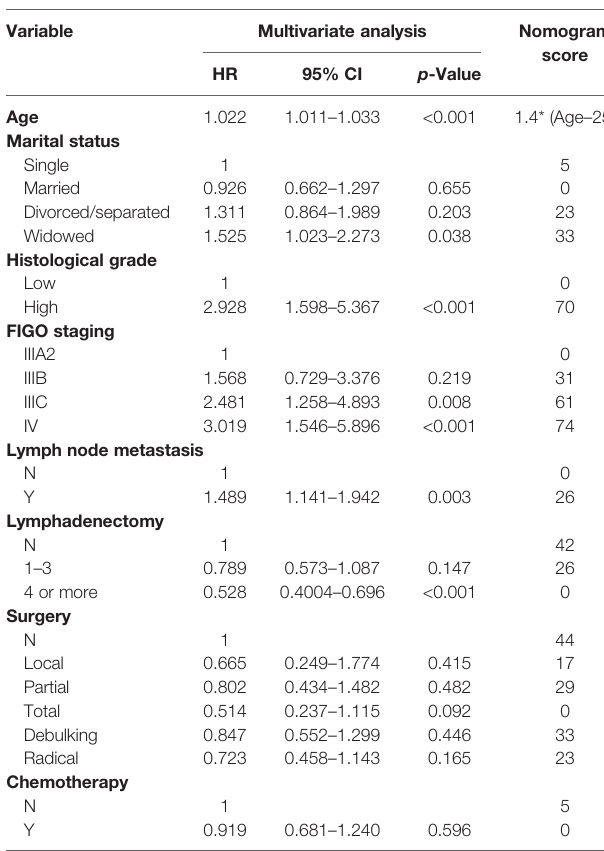
FIGO, the International Federation of Gynecology and Obstetrics. *means multiply by.